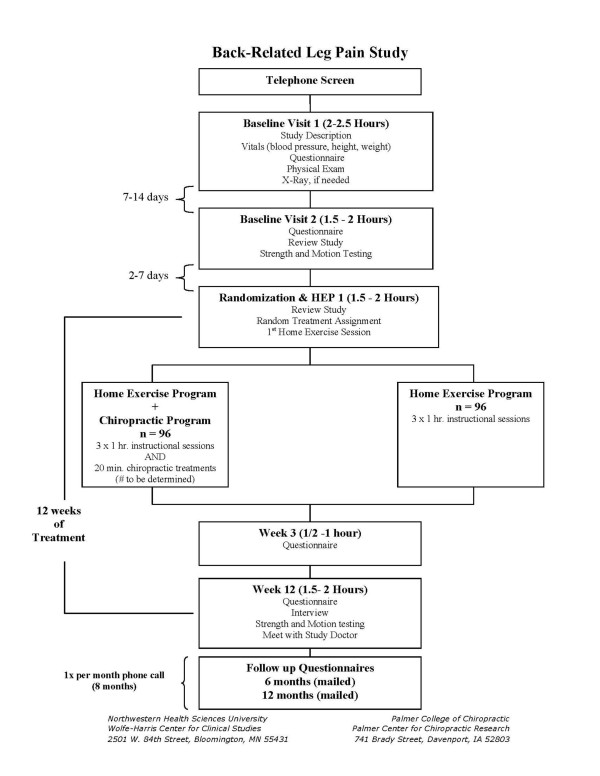
Participant Flow chart. Participant flow, study visits, and evaluations.